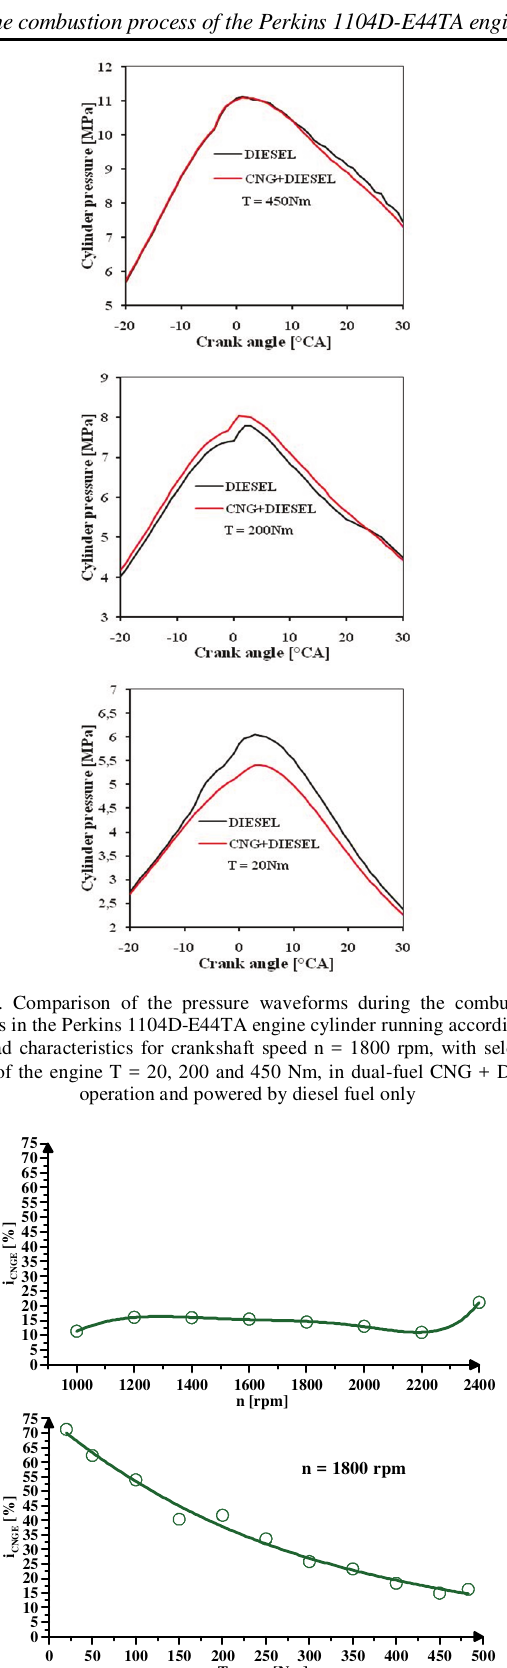
Fig. 5. Comparison of the pressure waveforms during the combustion process in the Perkins 1104D-E44TA engine cylinder operating according Fig. 7. The energy share of natural gas in the total energy input to the to external speed characteristics for selected crankshaft speeds n = 1400, cylinders of the Perkins 1104D-E44TA engine running in dual-fuel CNG + 1800 and 2200 rpm, in dual-fuel CNG + Diesel operation and powered by Diesel operation and according to external speed characteristics and load diesel fuel only characteristics for crankshaft speed n = 1800